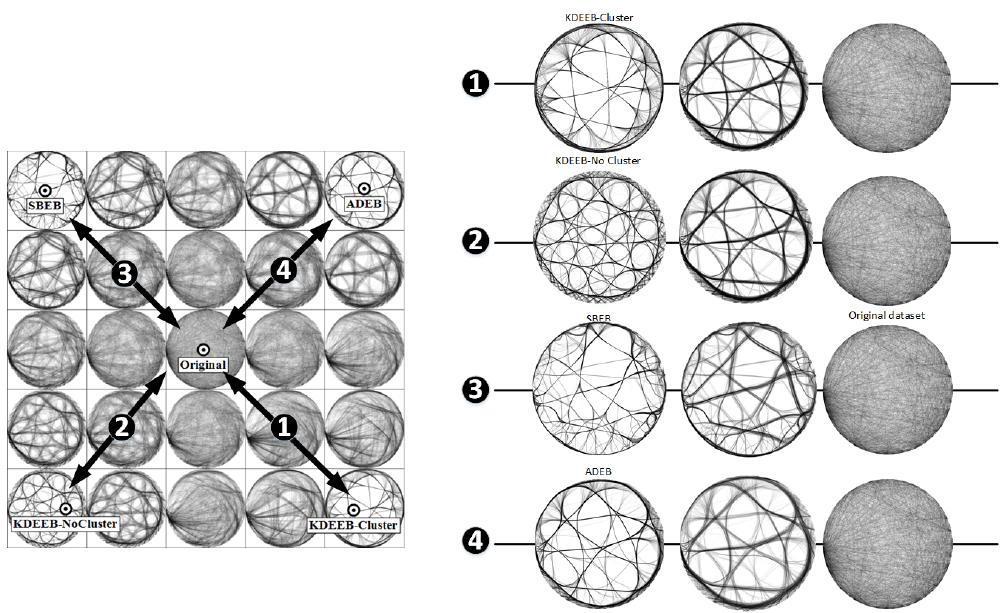
Figure 10. Bundling relaxation provided for four bundling techniques (presets in the corners of the grid) by our animation